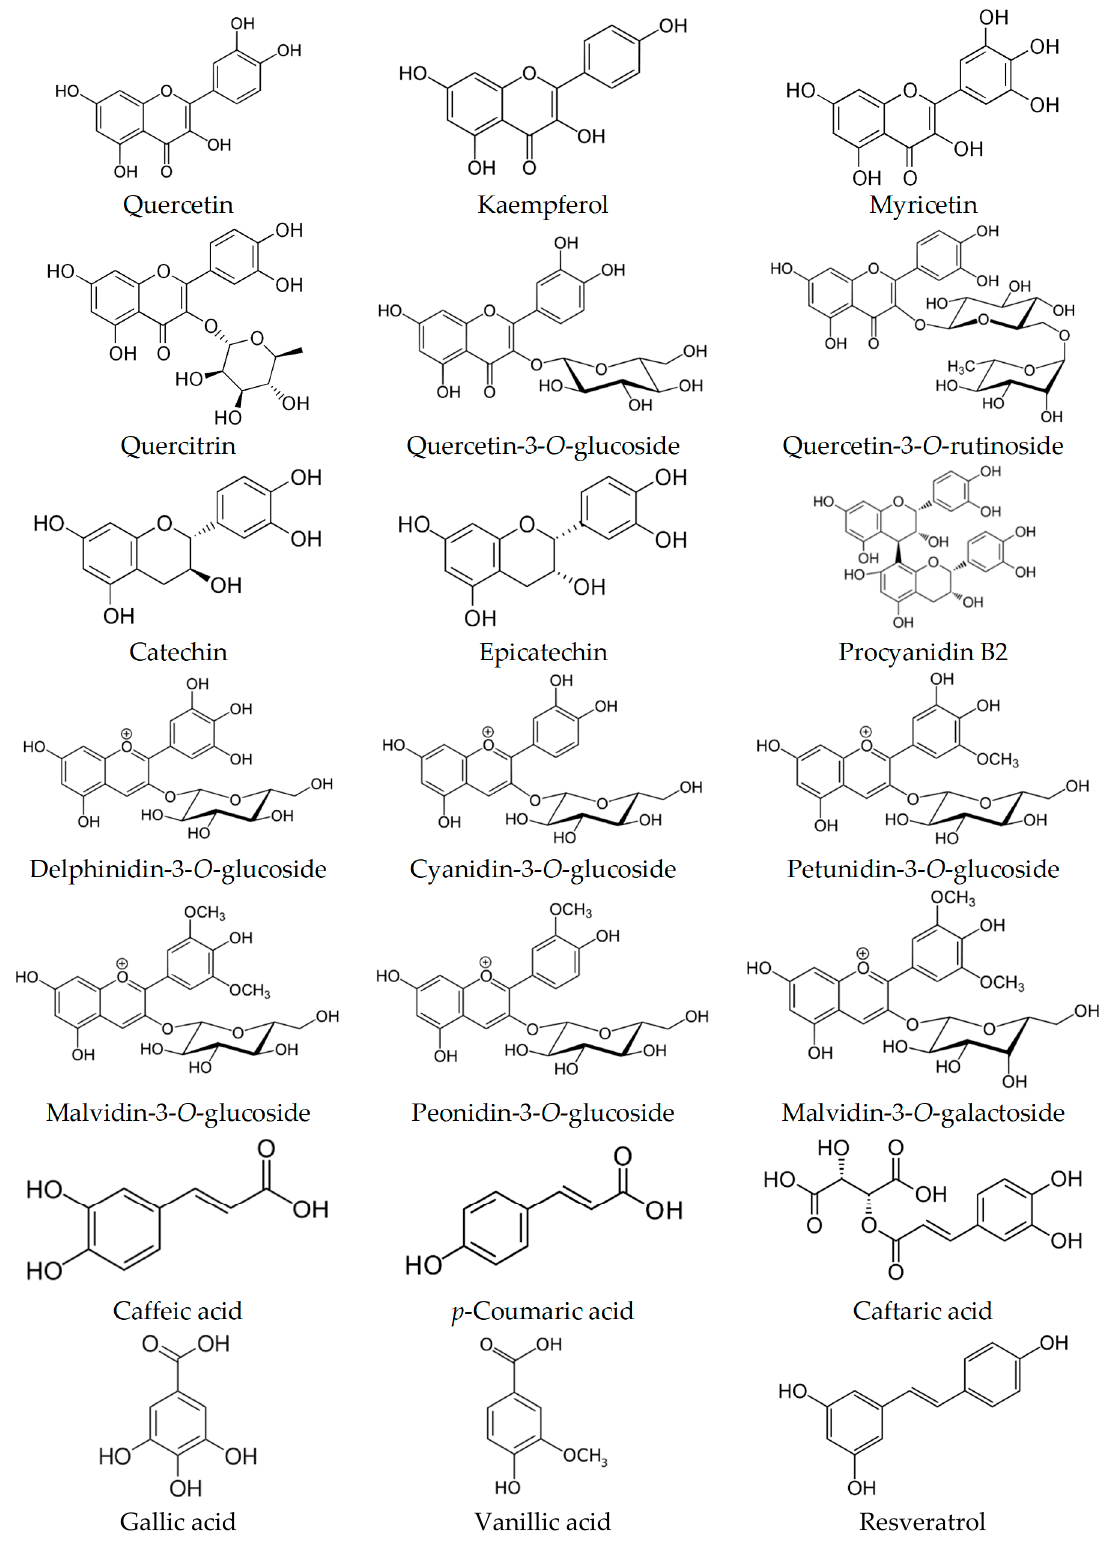
Figure 2. Chemical Structures of some phenolic compounds identified in wine lees.